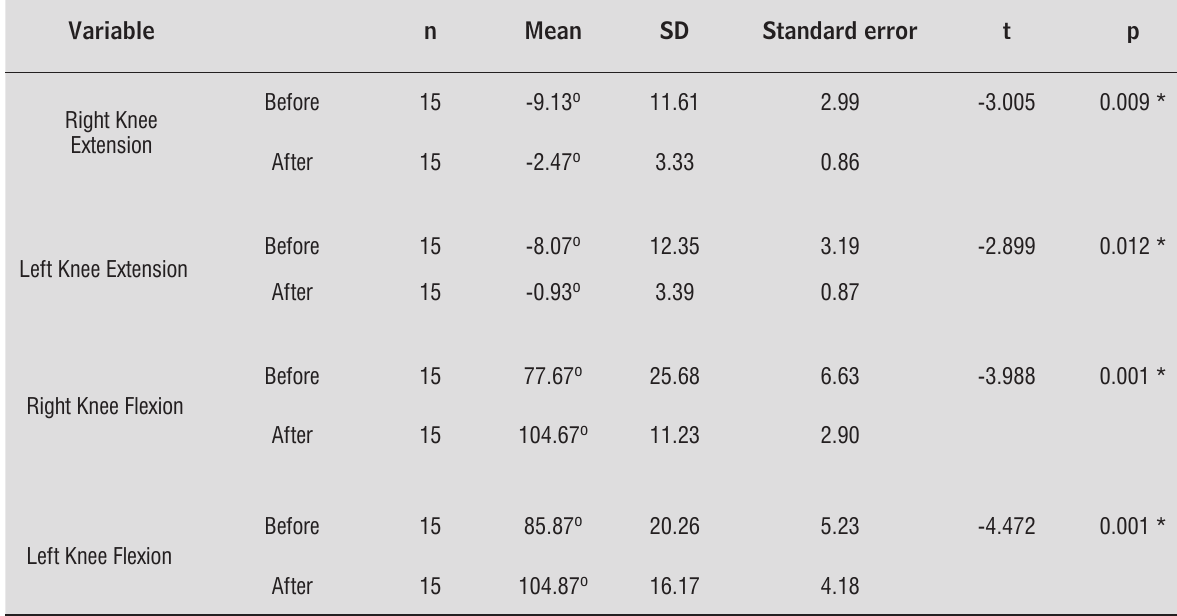
Table 4 - Range of Motion values of the knee movements before and after the treatment of GII (electrothermotherapy) of Elderly Women, São Luís, MA, 2009 Variable n Mean SD Standard Error p Before Right Knee Extension